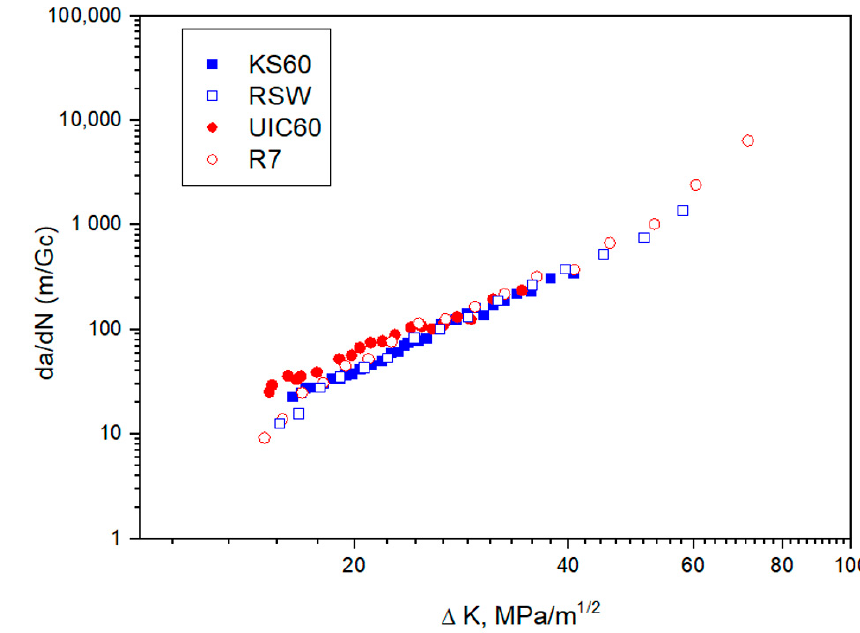
Table 4. FCGR characterizing parameters.